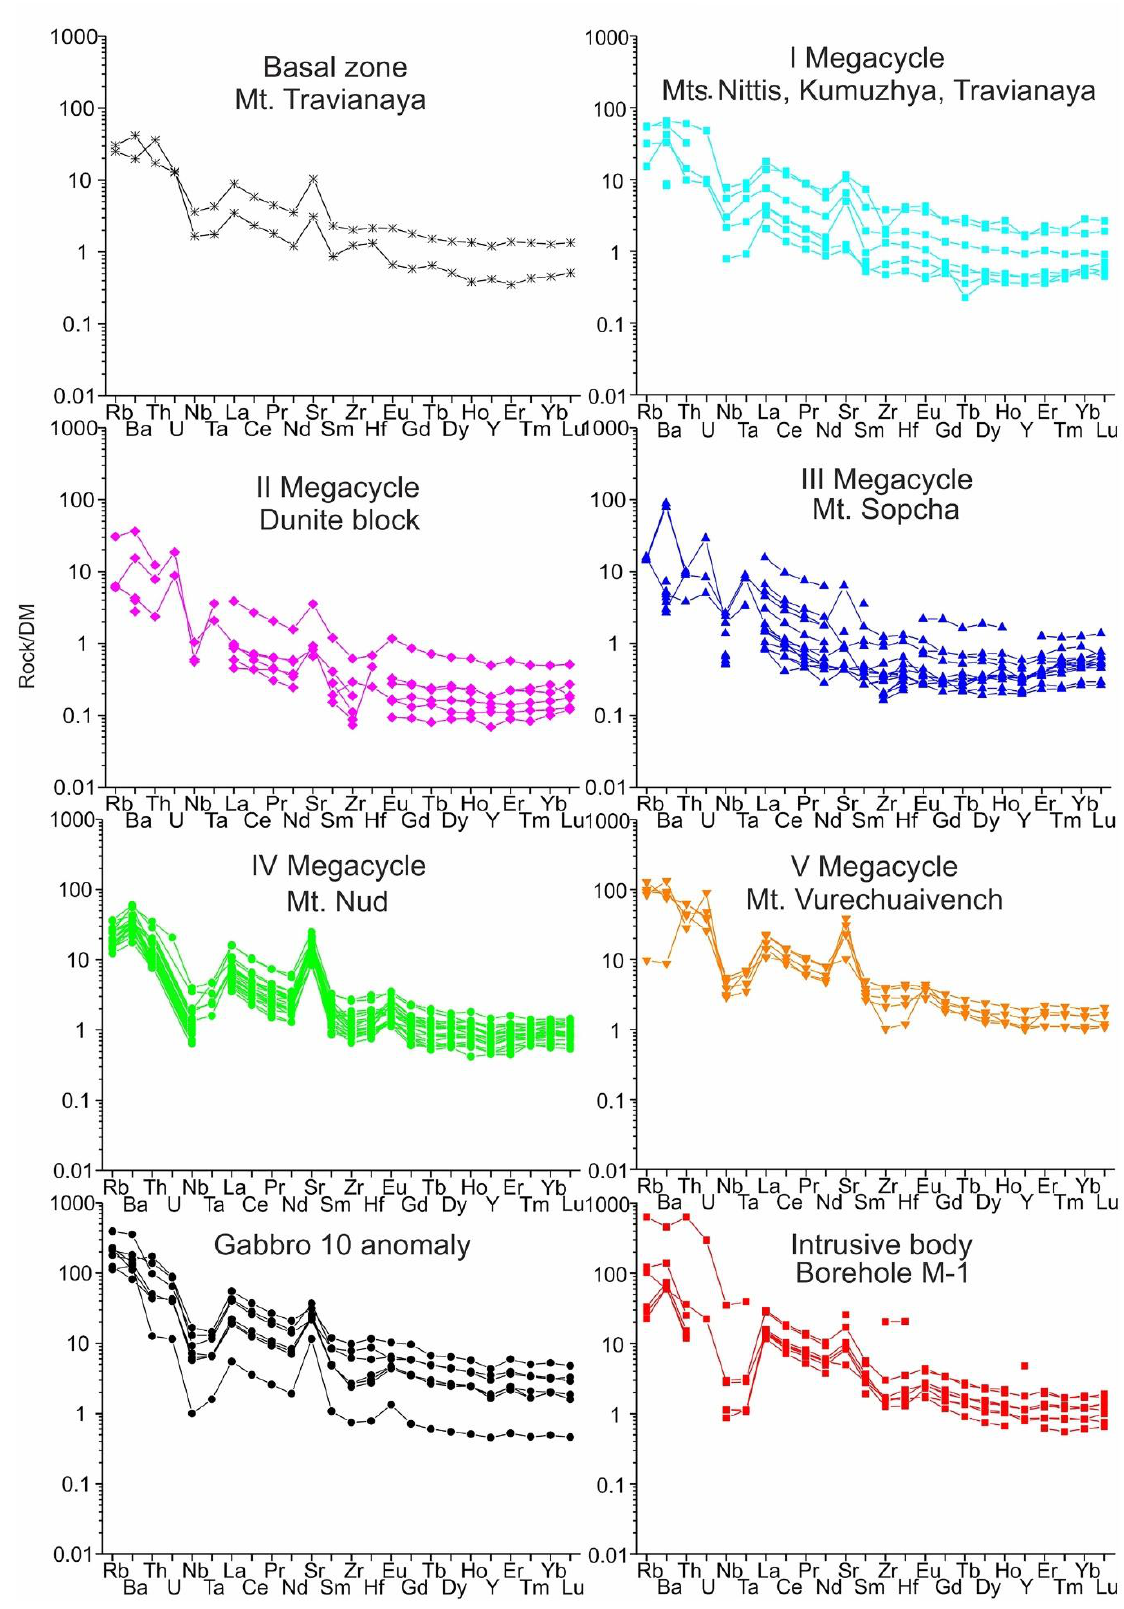
Figure 9. Spider-diagram of rocks in the Monchepluton and intrusive body normalized to DM [32].